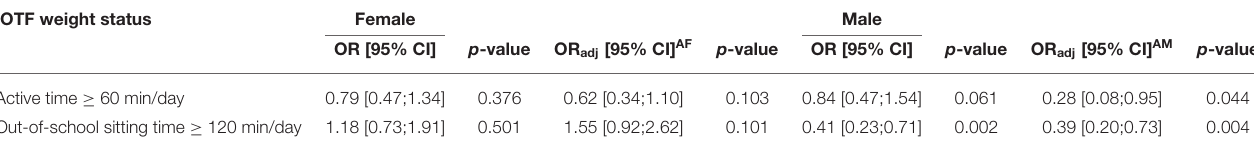
TABLE 3 | Association between PA and out-of-school sitting time with weight status (being overweight) in female and male adolescents. IOTF weight status